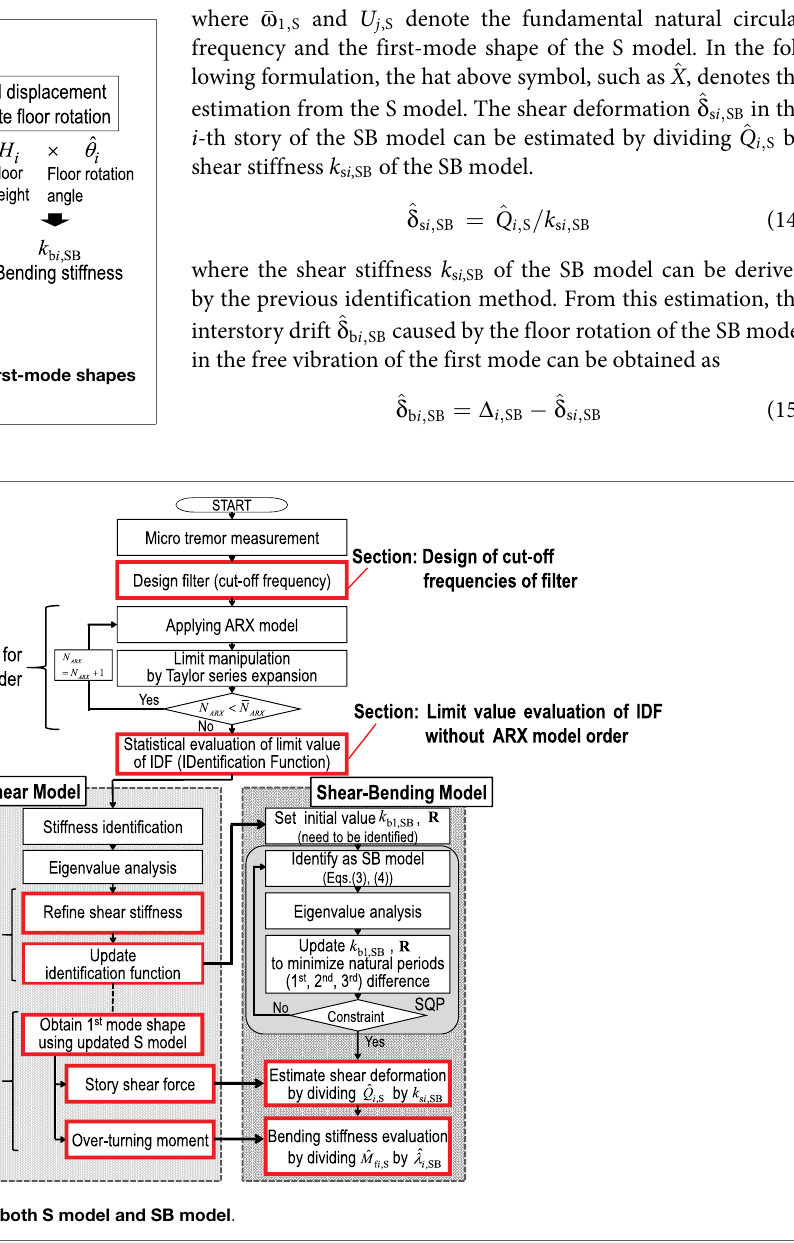
Figure 6 . Let m i denote the i -th mass of the S model and the SB model and let I i denote the i -th mass moment of inertia of the SB model. Those are given as known parameters. The story stiffnesses of the S model can be derived from the theory using the IDF.